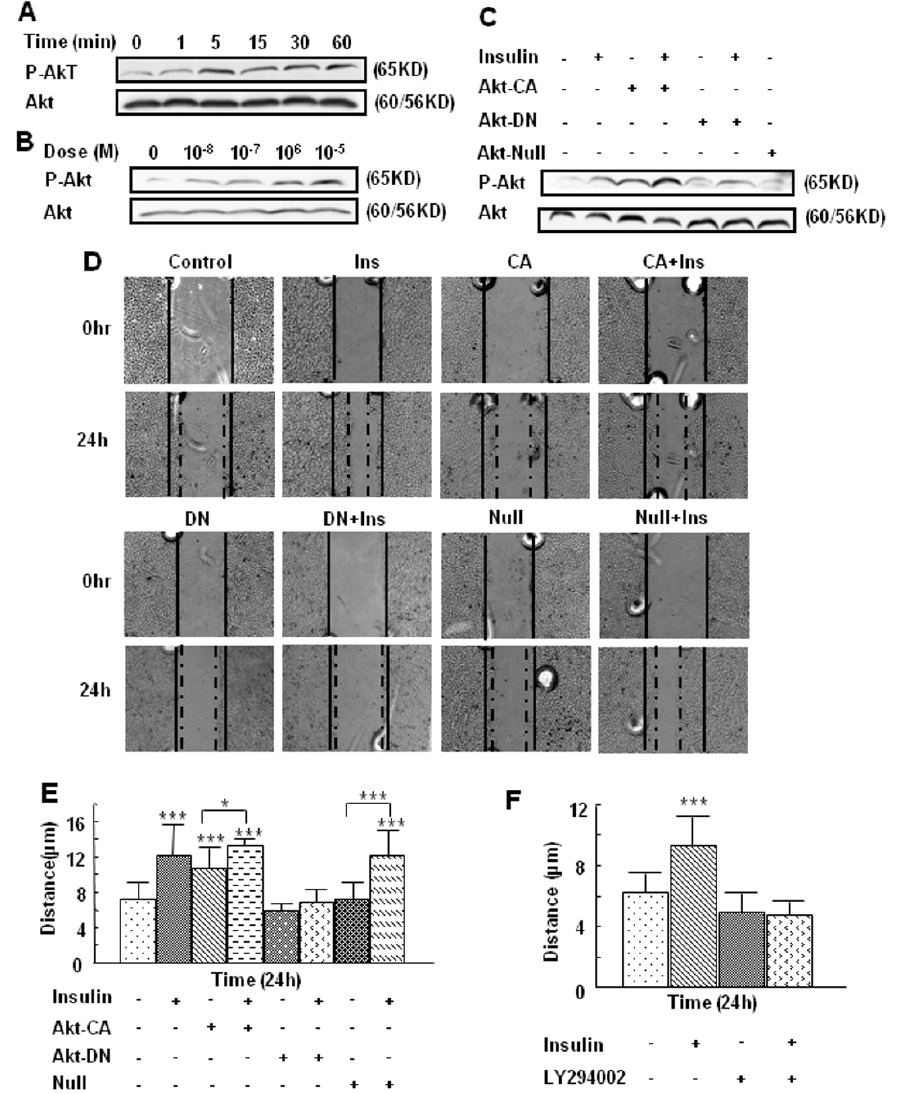
Figure 4 PI-3K and Akt mediate insulin-induced keratinocyte migration . (A) HaCaT cells were either left untreated or treated with 10 -7 M insulin for the indicated time points, followed by immunoblot analysis of the cell lysates using an Ab that specifically recognizes phosphorylated Akt at Ser 473. This blot was reprobed with an Ab to Akt to ensure equal loading. Insulin increased Akt phosphorylation over time, with peak phosphorylation seen at 5 min. (B) HaCaT cells were either left untreated or treated with 10 -8 M to10 -5 M insulin for 5 min, and then analyzed as in (A). Insulin stimulated phosphorylation of Akt in a dose- dependent manner. (C) HaCaT cells grown to 60–70% confluence were infected with adenovirus expressing constitutively active Akt (Akt-CA), dominant-negative Akt (Akt-DN) or the null adenovirus (Null) by incubating cells with the adenovirus for 5 h. Forty-eight hours after infection, cells were treated with 10 -7 M insulin for 3 min or left untreated. Phosphorylation of Akt and total Akt were detected by immunoblot. The Akt-DN inhibited insulin-induced Akt phosphorylation. (D, E) HaCaT Cells grown to 50–60% confluence were infected with adenovirus expressing Akt-CA, Akt-DN, or null adenovirus, as mentioned above. Forty-eight hours after infection, scratch wounds were made, and cells were treated with10 -7 M insulin; migration dis- tances were measured after 24 h of treatment. Again expression of the Akt-DN inhibited insulin-induced migration. (F) HaCaT cells were incubated with 50 μ M of the PI3K inhibitor LY294002, 10 -7 M insulin, or LY294002 for 1 h, followed by treatment with 10 -7 M insulin. The migration distances were measured 24 h after treatment. Insulin induced keratinocyte migration was abolished by pre-treatment with the PI3K inhibitor LY294002. Results are representative of at least three independent experi- ments. *P < 0.05 vs control; ***P < 0.001 vs